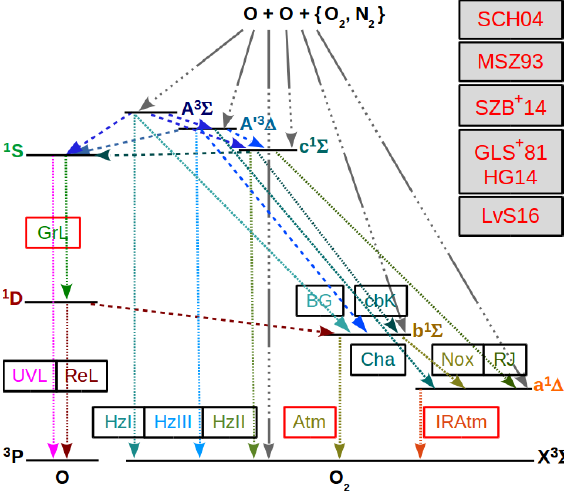
Figure 1. O 2 and O term diagrams showing processes of the MAC model comprised of processes considered in the G, M and H models and extended with complementary C processes. C pro- cesses are proposed to couple states of O 2 ( 5 (cid:53), A, A (cid:48) , c, b, a, X) and O ( 1 S, 1 D, 3 P) with each other according to the hypothesis of Slanger et al. (2004b) (SCH04) stating that the Herzberg states are in constant collisional communication with the higher excited 5 (cid:53) electronic state. All considered processes of the MAC model are provided in Tables 5, 6 and 7. Greer et al. (1981) (GLS + 81) and Huang and George (2014) (HG14) considered the G processes, Mlynczak et al. (1993) (MSZ93) and Sharp et al. (2014) (SZB + 14) the M processes, and Lednyts’kyy and von Savigny (2016) (LvS16) the C processes. Three-body recombination (association) reactions are indicated by the gray line shown by many dots and one long dash; they result in O 2 ∗ and O 2 ∗∗ due to reactions with the rate values βκ 1 and ακ 1 , respectively, (McDade et al., 1986). Radiative losses and quenching processes are indicated by an abbreviation near the fine dashed line; see Table 1 for abbreviations. Radiative losses only are also indicated by an abbreviation. Quenching pro- cesses only are indicated by the dashed lines. The O 2 (A, A (cid:48) , c) Herzberg states are all implemented as possible O ( 1 S) precur- sors because their energy in various vibrational levels exceeds the 4.19eV excitation energy difference with respect to the triplet O 2 (X) ground state.